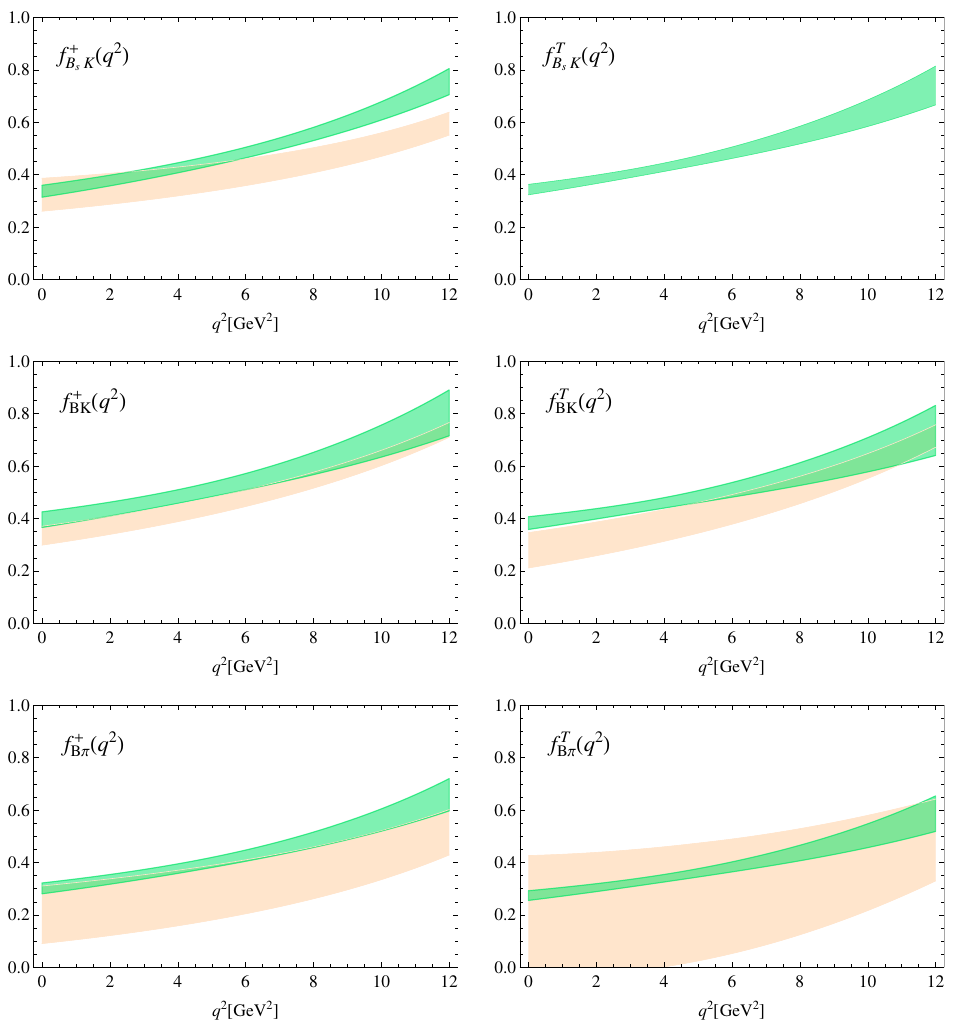
Figure 1 . The vector (tensor) form factors of B s ! K , B ! K and B ! (cid:25) transitions calculated from LCSRs including estimated parametrical uncertainties are shown on the upper, middle and lower left (right) panels, respectively, with the dark-shaded (green) bands. Extrapolations of the lattice QCD results for B s ! K [23], B ! K [25] and B ! (cid:25) [27, 28] form factors are shown with the light-shaded (orange)